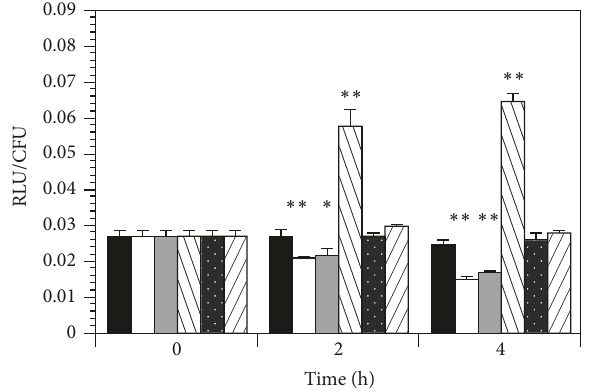
Figure 2: Effects of fimB transcription in strain NU149/pWS145- 38 containing a fimB-lux transcriptional fusion grown in a pH 5.5 or 7 environment mixed with plain Sepharose beads, mannose- coated Sepharose beads, of mannose-coated Sepharose beads with 2% free mannose (wt/vol) added. Columns represent NU149 grown in pH 5.5 LB mixed with mannose-coated Sepharose beads (black column),plainSepharosebeads(whitecolumn),ormannose-coated Sepharose beads plus 2% free D-mannose (gray column) as well as NU149 grown in pH 7 LB mixed with mannose-coated Sepharose beads (left striped column), plain Sepharose beads (white dots column), or mannose-coated Sepharose beads plus 2% free D- mannose (right striped column). The RLU/CFU were calculated by using a luminometer to measure luminescence, subtracting out the background, and then dividing by viable counts. The data represents thatthemeans ± standarddeviationsareindicatedfromatleastthree separate runs. ∗ equals 𝑃 < 0.05 and ∗∗ equals 𝑃 <